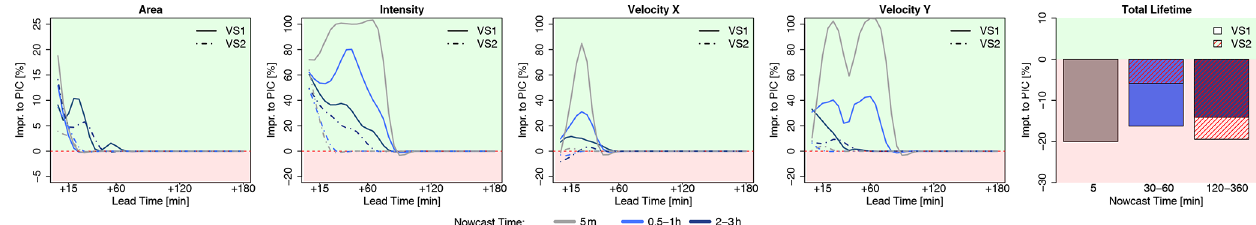
Figure 7. The median mean absolute error (MAE) improvement per lead time and target variable from applying the k -NN (VS1 target-based, VS2 storm-based) with the predictors and weights derived by the Pearson correlation instead of PIC. The improvements are averaged for different times of nowcast. The green plot region indicates a positive improvement of the correlation predictors in comparison to the PIC, and the red region indicates a deterioration.